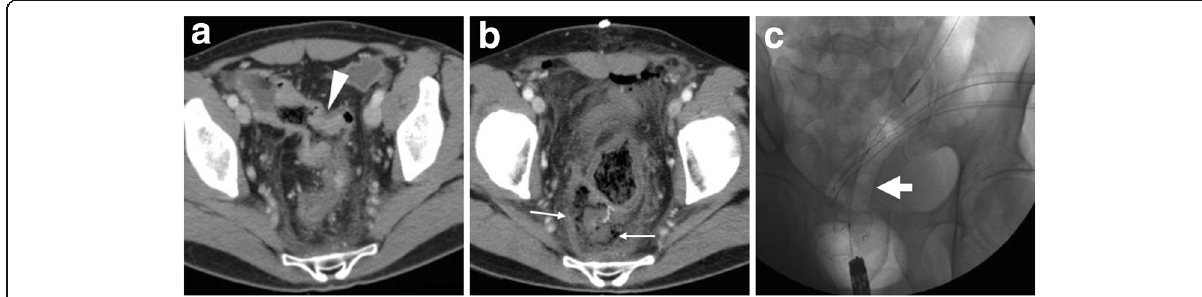
Fig. 11 Successful stent management of anastomotic leak (AL). After the CT diagnosis of CRC at the distal sigmoid colon (arrowhead in a ), an elderly male underwent surgical resection with primary anastomosis. Early postoperative CT ( b ) showed inhomogeneous collection (thin arrows) containing gas bubbles, located between the anterior aspect of the sacrum and the colorectal anastomosis site, consistent with clinical suspicion